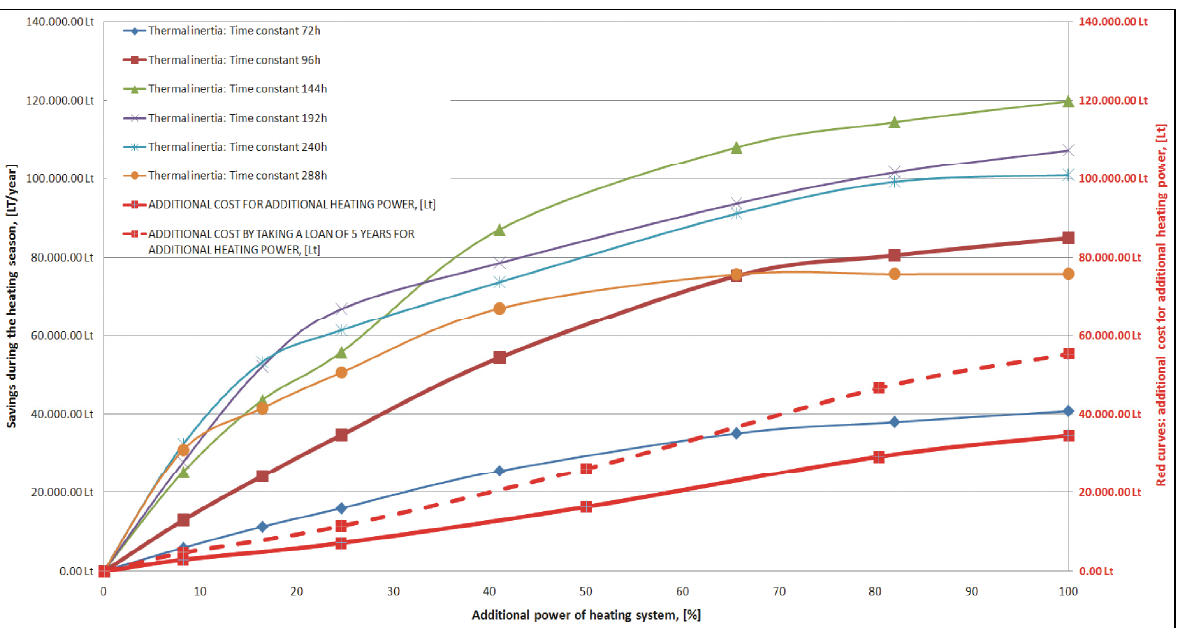
Fig. 10. Savings of thermal energy during the heating season by use of intermittent heating and additional power of heating system in various cases of thermal time constant